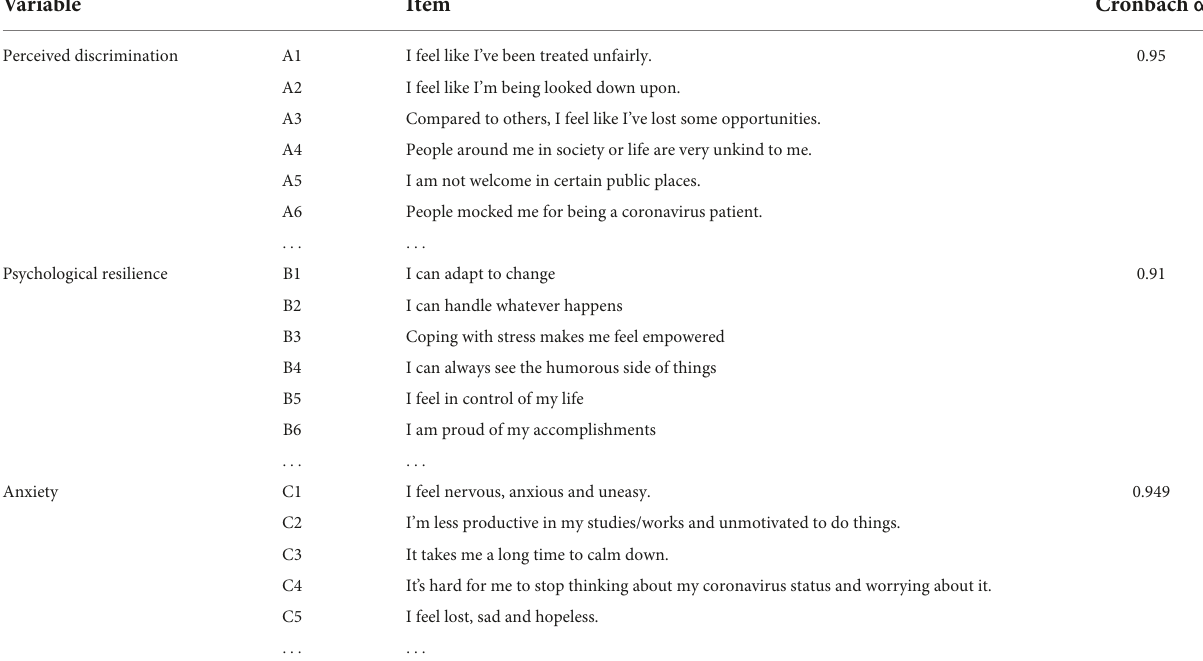
TABLE 2 Reliability test and descriptive for study variable. Variable Item